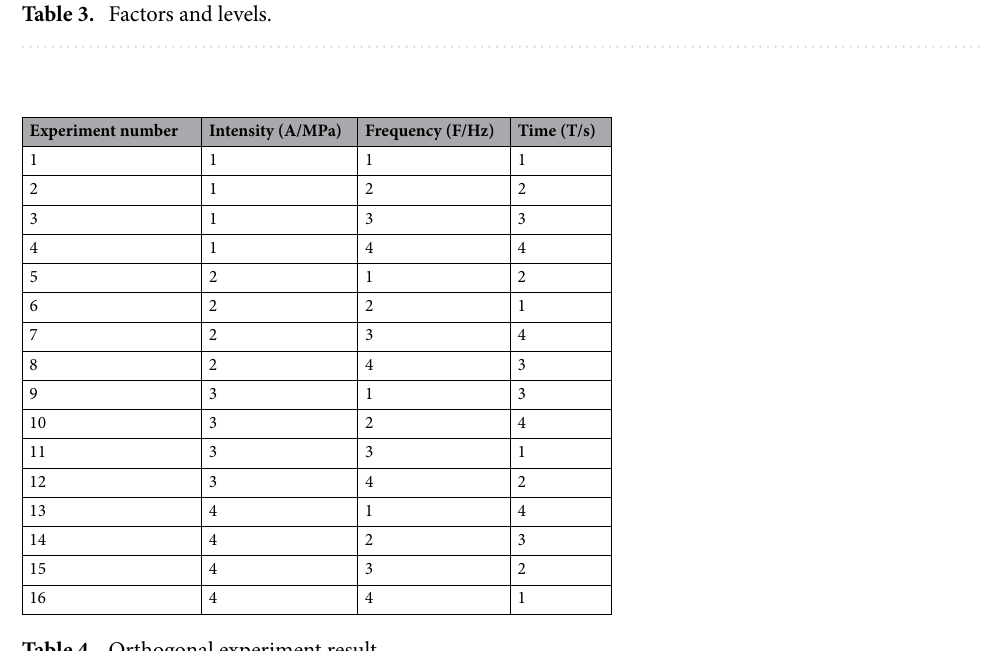
Table 4. Orthogonal experiment